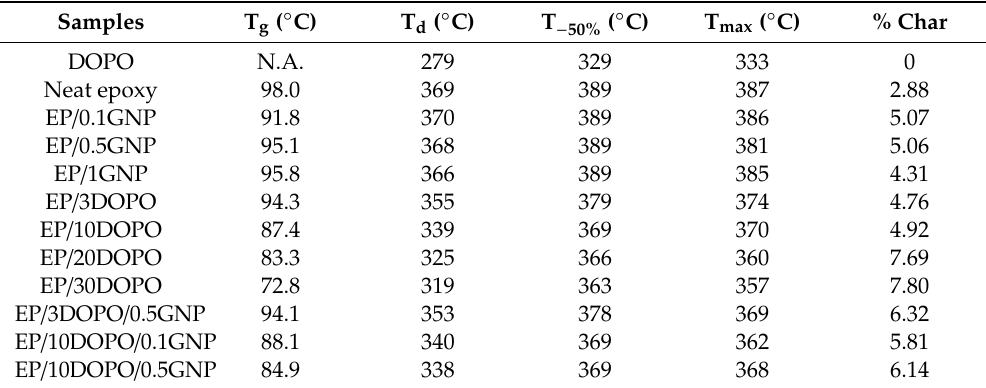
Figure 7. ( a , c , e ) TGA and ( b , d , f ) DTG curvesfrom thermogravimetric analysis under the nitrogen Figure 7. TGA and DTG curves from thermogravimetric analysis under the nitrogen environment of environment of DOPO, GNP, cured neat epoxy resin, EP / GNP, EP / DOPO, and EP / DOPO / GNP. DOPO, GNP, cured neat epoxy resin, EP/GNP, EP/DOPO, and EP/DOPO/GNP . Table 2. Glass transition temperatures (T g ) and thermogravimetric analysis data of DOPO, neat epoxy, EP / GNP, EP / DOPO, and EP / DOPO / GNP